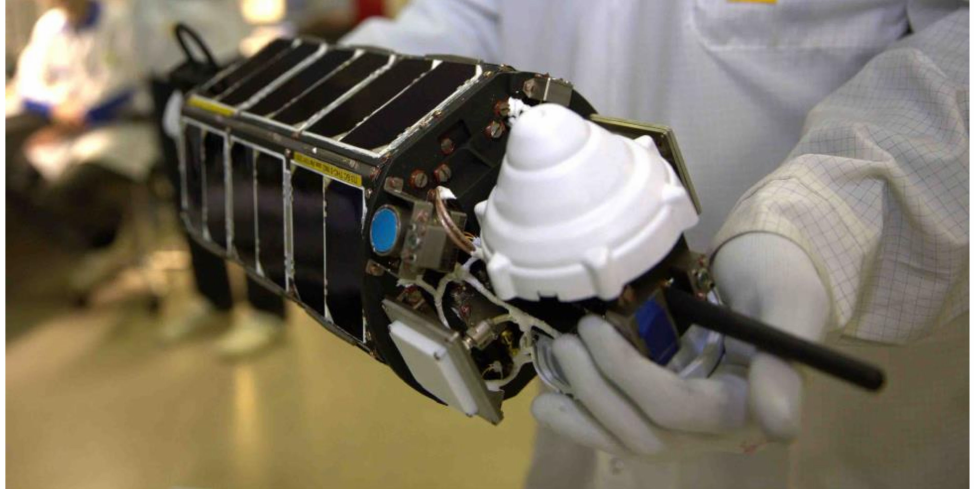
Figure 1. TNS-0 #2 nanosatellite (Credit: JSC Russian Space